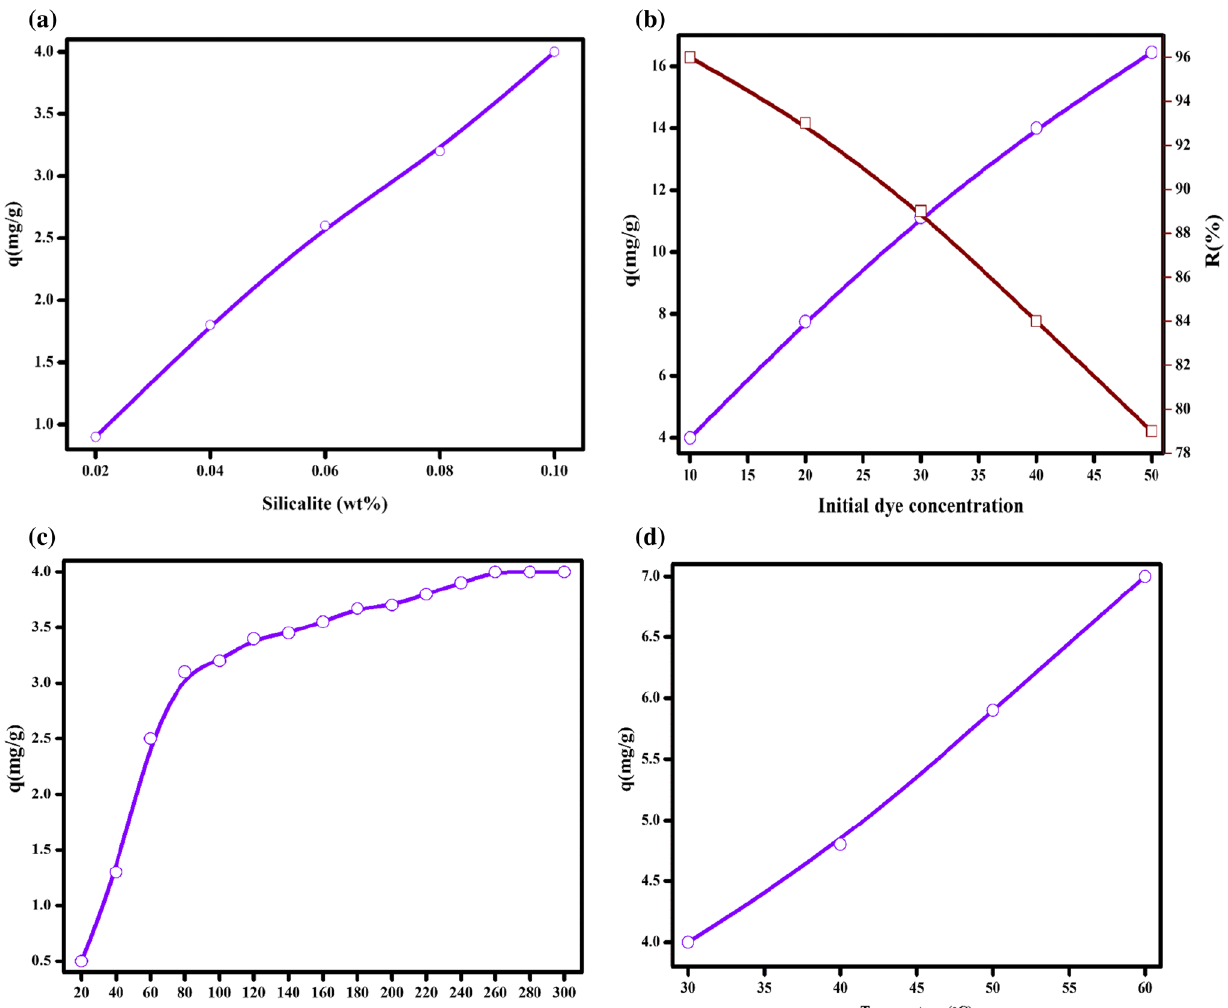
Fig. 8 Effect of various parameters on the adsorption of MB onto mesoporous silicalite-1 a silicalite-1 dosage b initial dye concentra- tion c contact time d temperature on the adsorption process